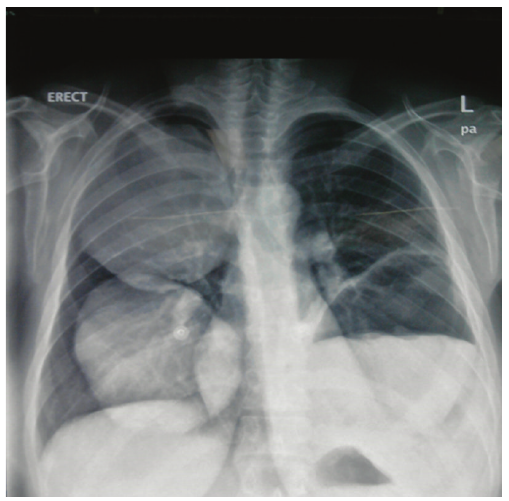
Figure 1: Chest X-ray revealed two fairly large unruptured hydatid cysts in the right lung and ruptured hydatid cyst in the left lung.